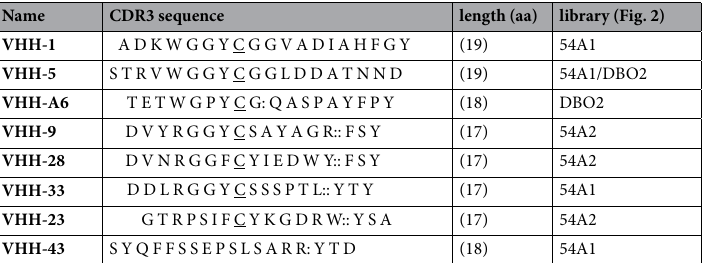
The purified VHHs were then analyzed with respect to their neutralizing capacity against a panel of 21 pseu- doviruses derived from several HIV-1 subtypes and neutralization sensitivities (4 tier 1, 16 tier 2 and 1 tier 3). Among these are all 12 strains from the extended global panel of HIV-1 reference strains for standardized assess- ment of vaccine-elicited neutralizing antibodies recently defined by deCamp et al . 45 . All eight VHHs showed neutralization of the more neutralization-resistant tier 2 pseudoviruses from at least two and up to six different subtypes including circulating recombinant forms (CRF) (Fig. 4). Interestingly, some VHHs showed complemen- tary neutralization patterns: VHH-A6 with the broadest spectrum of neutralization capacity (16/21 including the tier 3 strain TRJO.4551) neutralizes most efficiently subtype B pseudoviruses, whereas VHH-28 neutralizes most efficiently subtype C, but also the strains from subtypes A and G. Thus, the complementary neutralization pattern of VHH-A6 and VHH-28 covers 19 strains from our virus panel of 21, including the epidemiologically most relevant subtypes C and A. To proof this complementary neutralization pattern, we exemplarily combined nanobodies VHH-A6 and VHH-28 in neutralization assays with 4 HIV-1 pseudoviruses differentially neutralized by the single VHHs. In all cases, the combination broadened the neutralization activity, as it neutralized each virus tested according to the more active nanobody in the combination (Fig. 4). Surprisingly, VHH-1 did not neutralize the neutralization-sensitive tier 1 strains (3 subtype B and 1 subtype C), although it neutralized some tier 2 strains from subtypes A and C quite efficiently. Similarly, VHH-9 and VHH-28, the latter strongly neutralizing subtype C tier 2 strains, also neutralized only 1 of the 3 tier 1 subtype B strains and only weakly the subtype C tier 1B strain (ZM197M). Thus, nanobodies VHH-1, VHH-9 and VHH-28 rather seem not to recognize subtype B efficiently, irrespective of neutralization sensitivity. For two of the broadest neutralizing VHHs, VHH-9 and VHH-28, binding to optC SOSIPs by ELISA (Supplementary Figure S5) correlated with potent neutralizing activity of the optC pseudovirus (IC 50 0.03– 0.04 µ g/ml) (Fig. 4). Interestingly, both nanobodies are derived from the phage library 54A2 at timepoint t2 after the late second immunization boost with optC SOSIP (Fig. 2). VHH-23, also derived from the same library, binds more weakly to optC SOSIP and shows a very narrow neutralization breadth: it does not neutralize the optC pseudovirus, but only the subtype B tier 1 viruses, one subtype C tier 2 strain and one subtype B tier 2 weakly (Fig. 4). VHH-A6 is also derived from a library of the late immunization timepoint (t2), but from animal DBO, which was immunized with the mixture of ZM197M and CAP45 SOSIPs. This nanobody shows intermediate binding to optC SOSIP, best binding to ZM197M (Supplementary Figure S5) and reveals the best neutralization breadth (16/21 strains including the tier 3 TRJO.4551). It also neutralizes the optC pseudovirus and the autolo- gous ZM197M, but not CAP45. VHH-23 and VHH-43 bind optC SOSIP, but do not neutralize optC and show very limited neutralization breadth. In contrast, VHH-33, VHH-1 and VHH-5 show lowest binding to optC SOSIP, but neutralize optC pseudovirus with an IC 50 of 0.7–3.2 µ g/ml and display intermediate neutralization breadth. This may indicate a slightly better exposure of the epitopes in the context of the pseudovirus compared to the respective SOSIPs. The binding to optC SOSIP and the neutralization breadth of the VHHs with respect to the pseudovirus panel was similar when reformatted into the human IgG1 Fc antibody format (Supplementary Figure S6 and Supplementary Table S1). Determination of epitopes for broadly neutralizing nanobodies. The different neutralization pat- terns observed for the selected VHHs may be due to the recognition of different epitopes. We attempted to eluci- date the epitopes targeted by the best neutralizing nanobodies first by competition ELISAs. These were performed with several monoclonal antibodies (mAbs) targeting well-known epitopes in Env including the CD4 binding site (CD4bs) (F105, b12, VRC01 CD4-Fc), CD4-induced (CD4i) epitopes (17b), the V2 apex (697–30D, PG9) or gp41 cluster I peptide (246-D), which we previously analyzed for binding to optC SOSIP (Supplementary Figure S1). Interestingly, except VHH-33, which did not compete with any of these mAbs, all the other VHHs competed with CD4bs ligands, although with different patterns (Fig. 5, Supplementary Table S2). VHH-33 does not bind to ZM197M SOSIP (Supplementary Figure S5); however, the fact that it binds and neutralizes optC suggests that this VHH recognizes an epitope different from those of the mAbs used for competition. In contrast, VHH-43 binds to both SOSIPs with intermediate strength, competes with most CD4bs mAbs on both, but only neutralizes mostly Tier 1 strains and HIV_25710_2.43 at low IC 50 . A similar pattern is seen for VHH-23; however, it binds only very poorly to ZM197M SOSIP consistent with a lack of neutralization of the ZM197M pseudovi- rus. For the other VHHs, the differential pattern of competition seen on optC and ZM197M SOSIPs with the CD4bs mAbs correlated quite well with differential binding of the VHHs to both SOSIPs: generally, VHHs bound